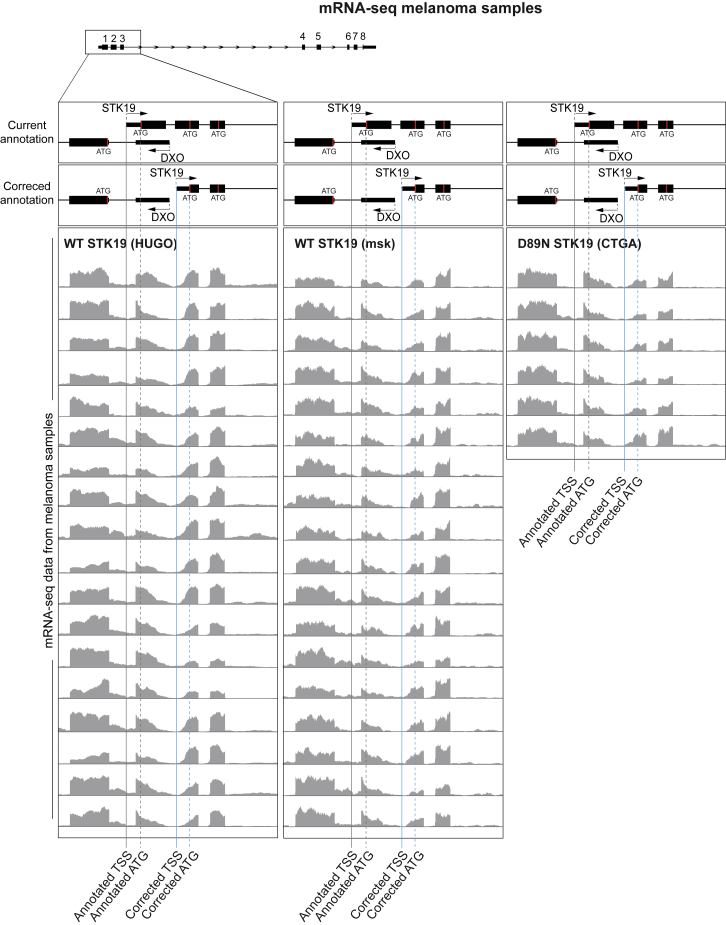
mRNA-seq Data from Melanoma Patient Samples to Compare wt STK19 and “D89N” STK19, Related to Figure 4Genome browser view of STK19’s 5′ region. STK19 5′ and DXO 5′ are visible. Current and corrected annotations are shown aligned to mRNA-seq of melanoma patient data. Data from two different datasets are shown for WT STK19 (18 samples each), and all 6 samples of “D89N” found in the CTGA database. TSS position is marked with a line for currently annotated (black) and corrected annotation (blue), and start codon (ATG) is marked by a dashed line for currently annotated (black) and corrected annotation (blue).